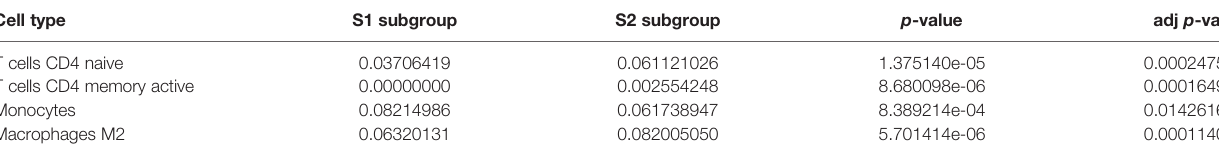
TABLE 2 | Characteristics of four signi fi cantly different tumor-in fi ltrating immune cells. Cell